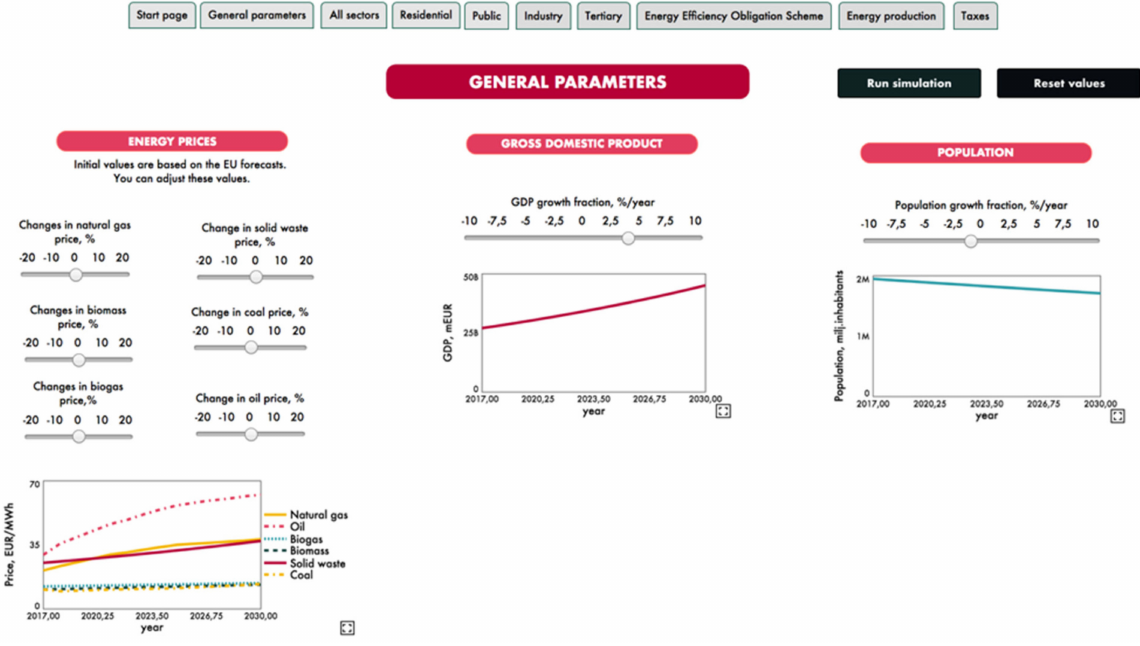
Figure A2. Internet-based model interface page for selection of general input